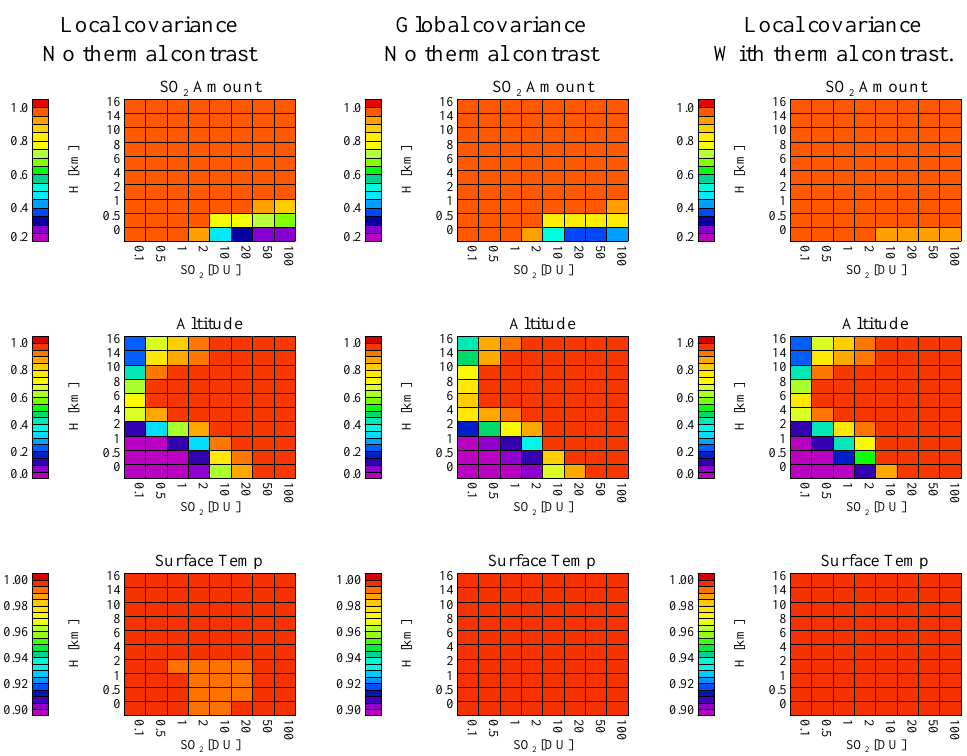
Fig. 4. Values of the averaging kernel (for SO 2 amount, altitude and surface temperature) as a function of SO 2 amount and altitude used in the simulations. The first column presents the values obtained computing the averaging kernel with the local error covariance matrix for April and no thermal contrast between surface and atmosphere. The second column presents the values using the global covariance matrix and no thermal contrast. The third column is obtained with the local covariance matrix and 10K of thermal contrast between surface and